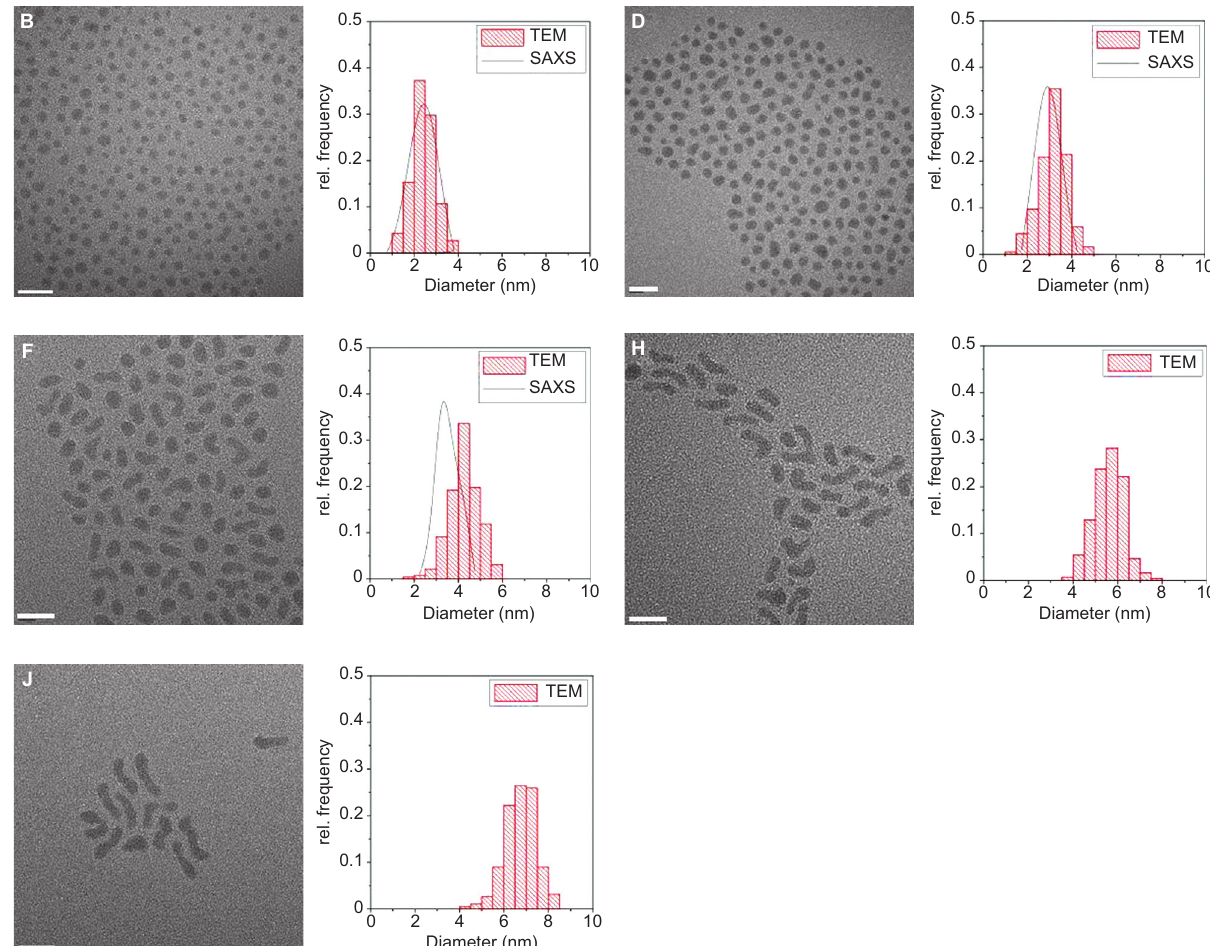
Figure 5 TEM images (B-J) and the corresponding particle size distribution from the TEM and from the fit of the SAXS profiles (see also Figure 8; B, D, F) using the IFT method (scale bar is 10